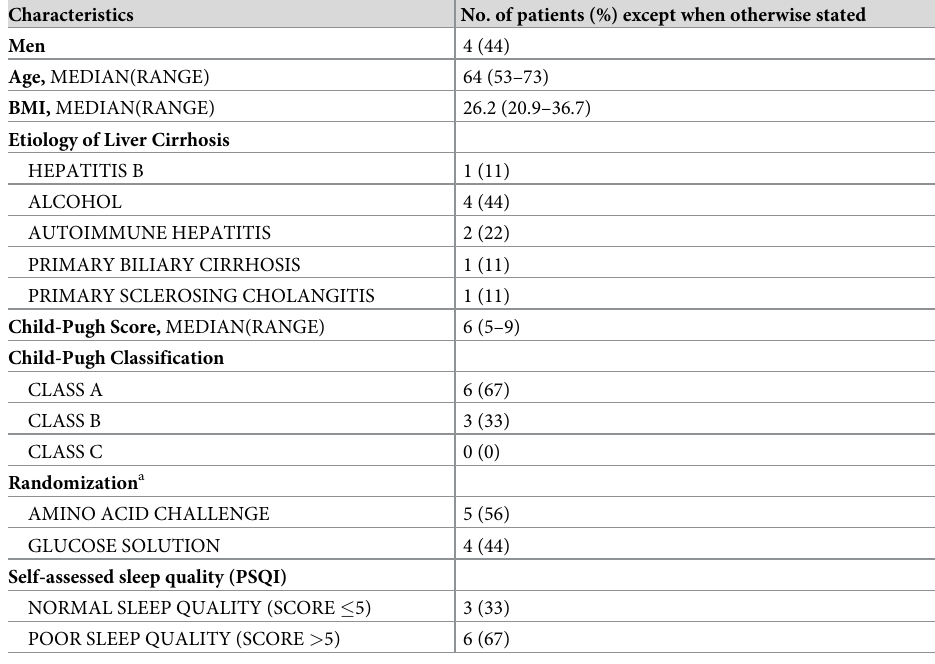
Table 2. The characteristics of the included patients with cirrhosis n = 9.